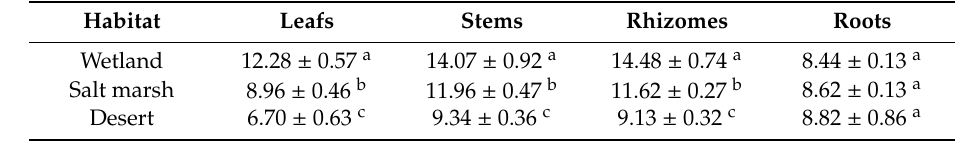
Table 3. Comparison of starch content in clonal modules of Phragmites communis in di ff erent habitats. Habitat Leafs Stems Rhizomes Roots Wetland